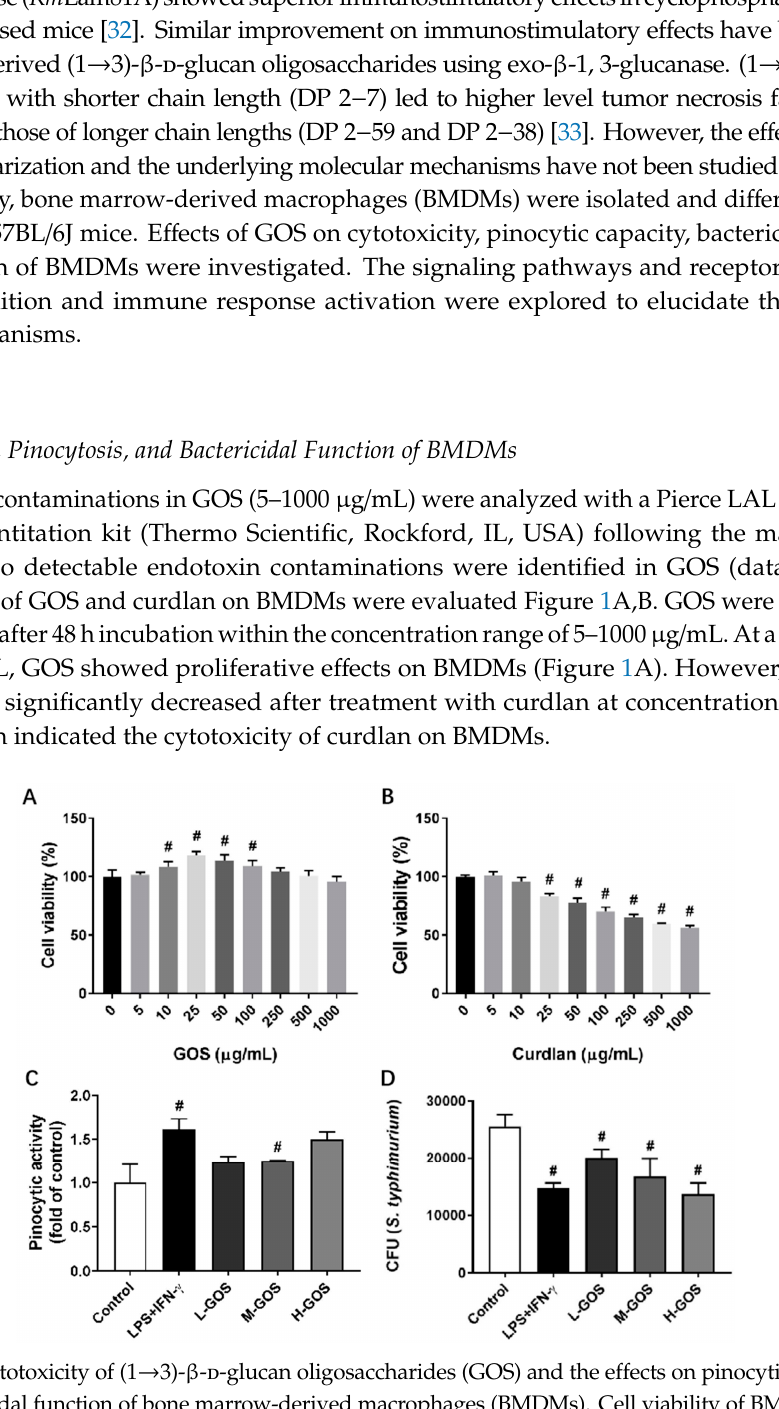
Figure 1. Cytotoxicity of (1 → 3)- β - D -glucan oligosaccharides (GOS) and the effects on pinocytic capacity and bactericidal function of bone marrow-derived macrophages (BMDMs). Cell viability of BMDMs was measured by MTT (3-(4,5-dimethylthiazol-2-yl)-2,5-diphenyltetrazolium bromide) assay after incubation with GOS (5 − 1000 µg/mL, ( A) ) and curdlan (5 − 1000 µg/mL, ( B) ) for 24 h. Pinocytosis of BMDMs was measured as the cellular uptake of fluorescein isothiocyanate (FITC)- dextran using fl ow cytometry after incubation with GOS (25 − 100 µg/mL) for 12 h at 37 °C ( C ). Bactericidal function of BMDMs was analyzed by counting the colony forming unit (CFU) of intracellular S. typhimurium after incubation with GOS (25 − 100 µg/mL) for 24 h ( D ). # —Indicated significant difference versus the control group at p <